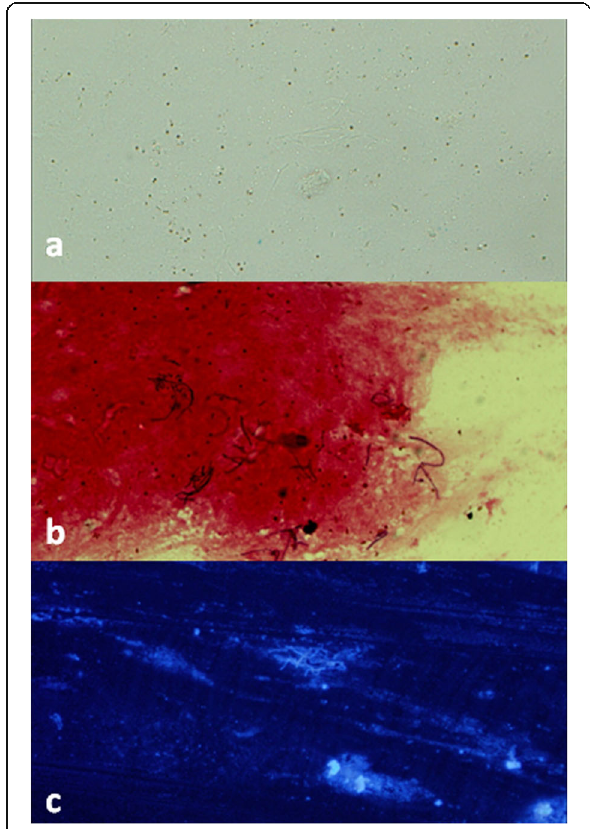
Fig. 2 Microscopy using white light source ( a ), Gram stain ( b ), and Calcofluor white staining ( c ) of Nocardia